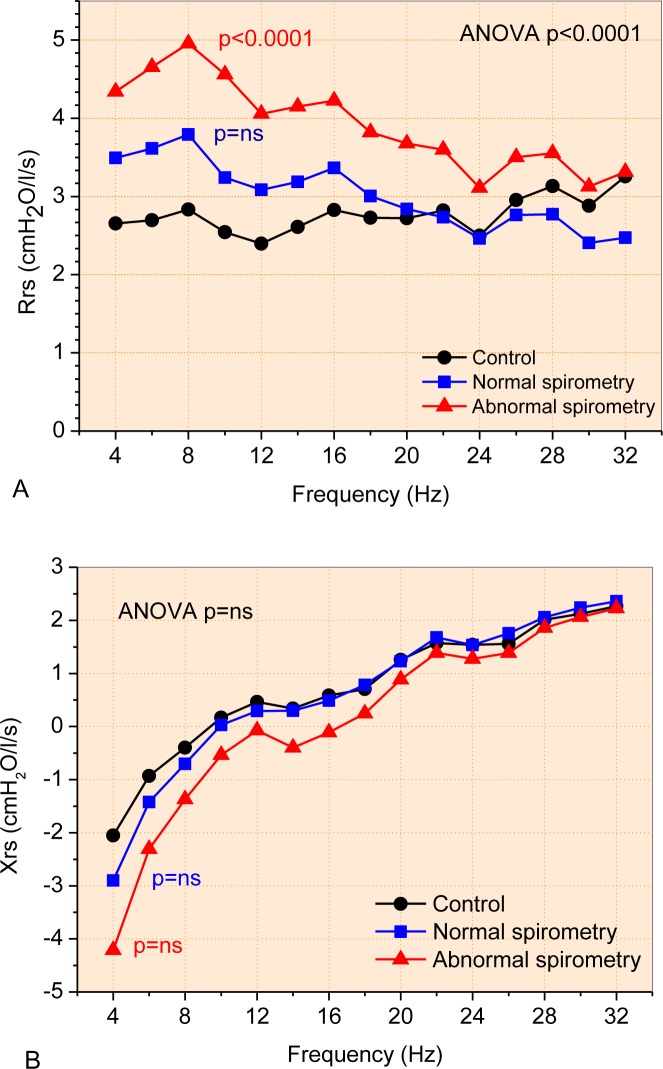
Changes in mean respiratory resistance (A) and reactance (B) curves as a function of frequency in patients with SCA.